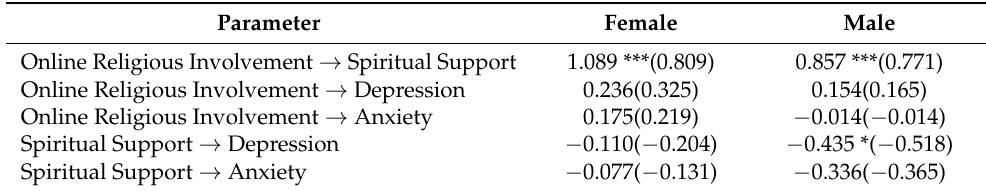
Table 4. Parameter estimates for female and male groups (model with equality constraint on factor loading).